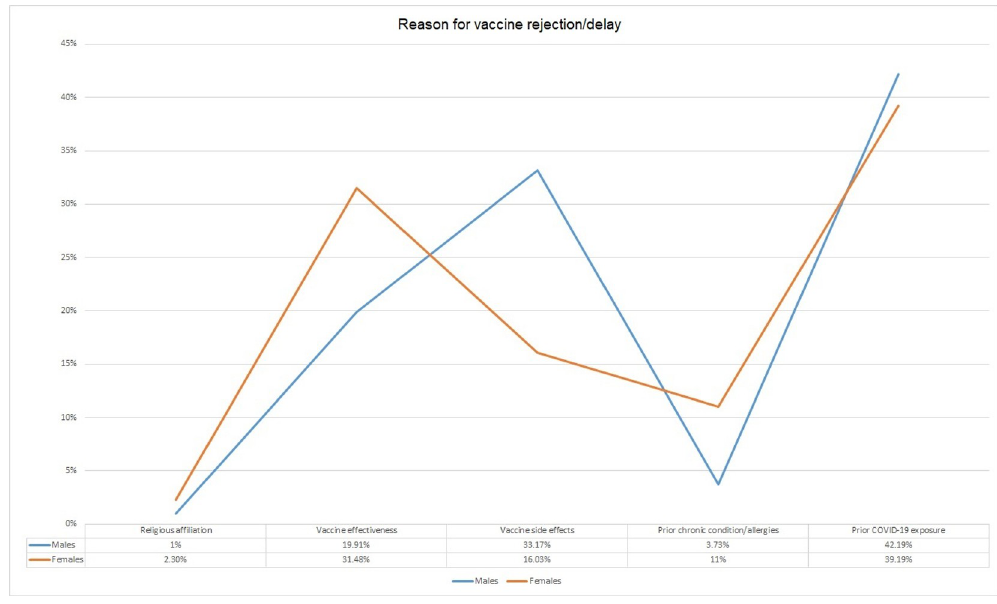
Fig 2. Views among genders regarding non-acceptance of